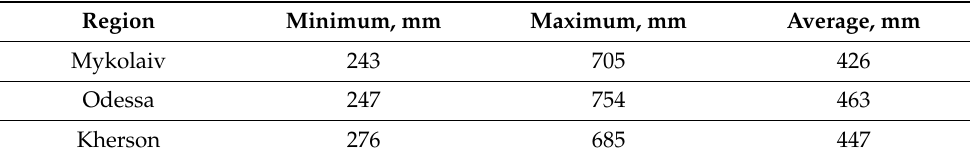
Table 4. Annual precipitation.